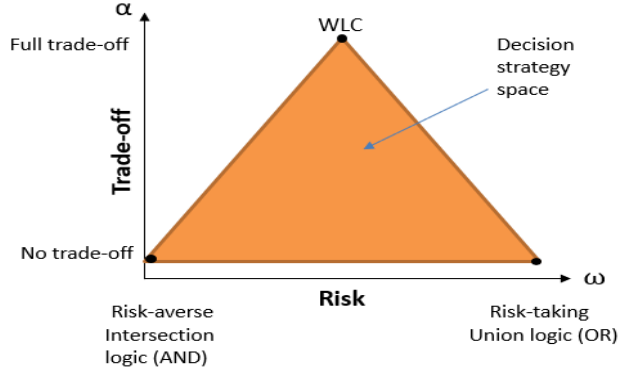
Figure 3. Decision strategy space in ordered weighted averaging (OWA) operations [45].